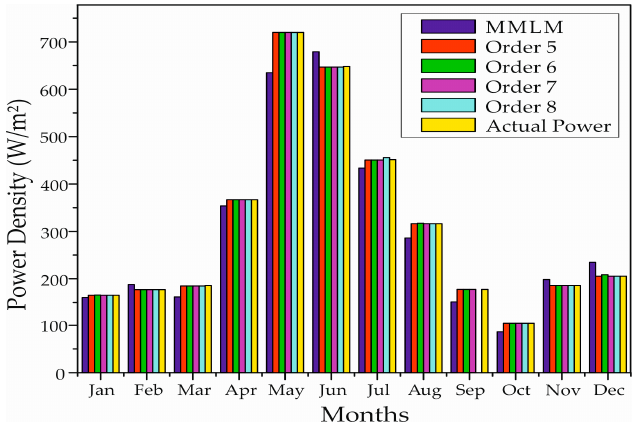
Figure 4. Power densities computed using MEP ‐ based functions at orders 5, 6, 7 and 8, Weibull function and actual wind speed data.